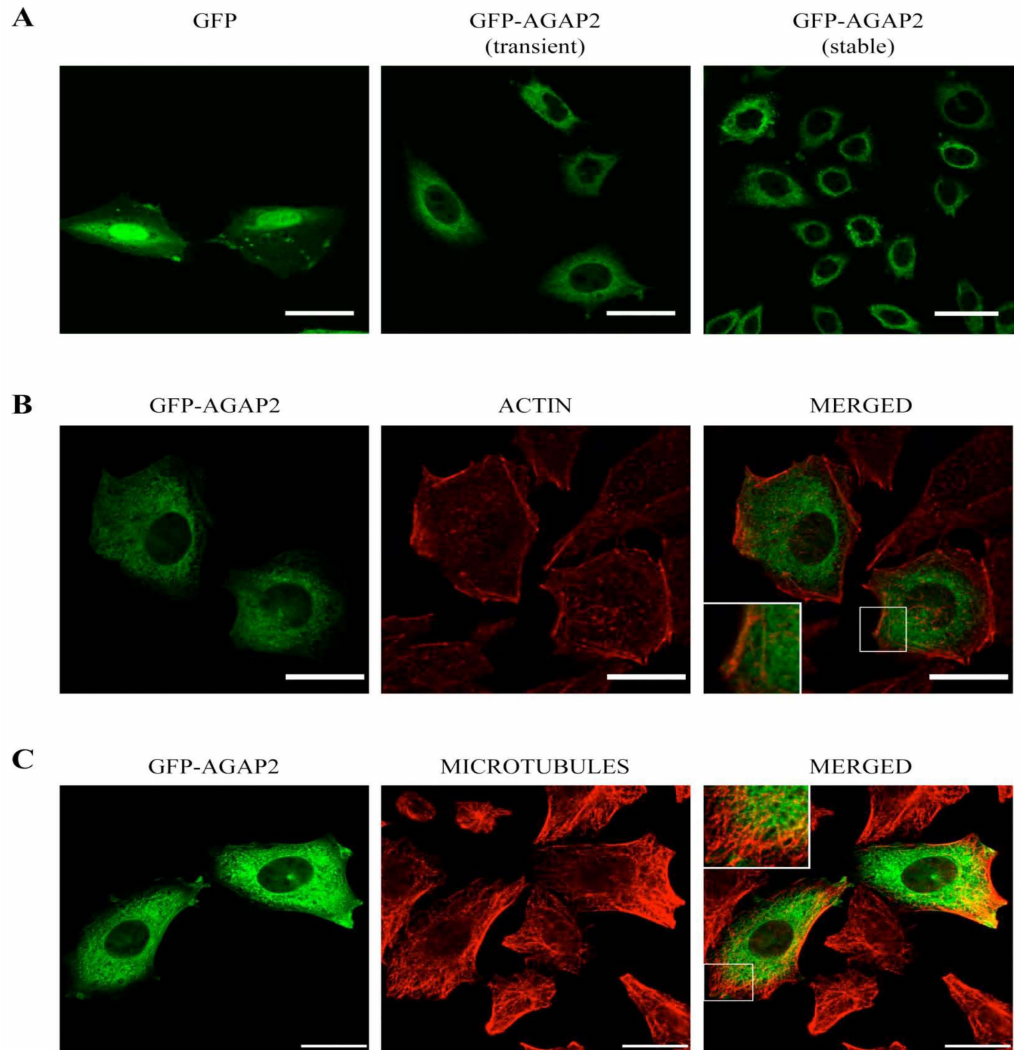
Figure 2. Co-localization of pEGFP-C1-AGAP2 with cytoskeletal proteins. ( A ) CHO-IIA cells tran- siently transfected with pEGFP-C1-AGAP2 or pEGFP-C1 alone and CHO-IIA cells stably expressing pEGFP-C1-AGAP2 were examined by confocal microscopy. CHO-IIA cells transiently expressing pEGFP-C1-AGAP2 were stained for filamentous actin with Alexa Fluor 594-conjugated phalloidin ( B ) or microtubules with anti- α -tubulin antibody ( C ). A single confocal cross section of cells is represented. Insets in ( B , C ) show a magnification of the boxed areas. Bars, 20 µ